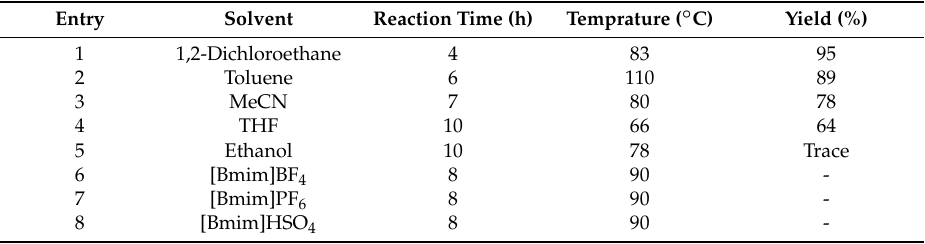
Table 1. Optimization of reaction conditions for the synthesis of 3a